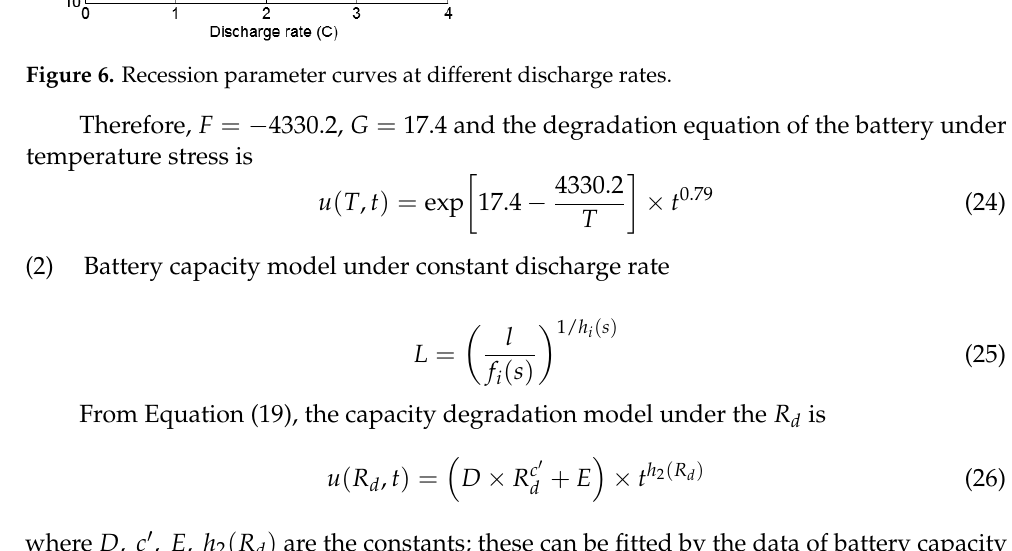
Figure 5. Capacity degradation curves at different discharge rates. Figure 7. Fitting curves of capacity degradation at different temperatures.